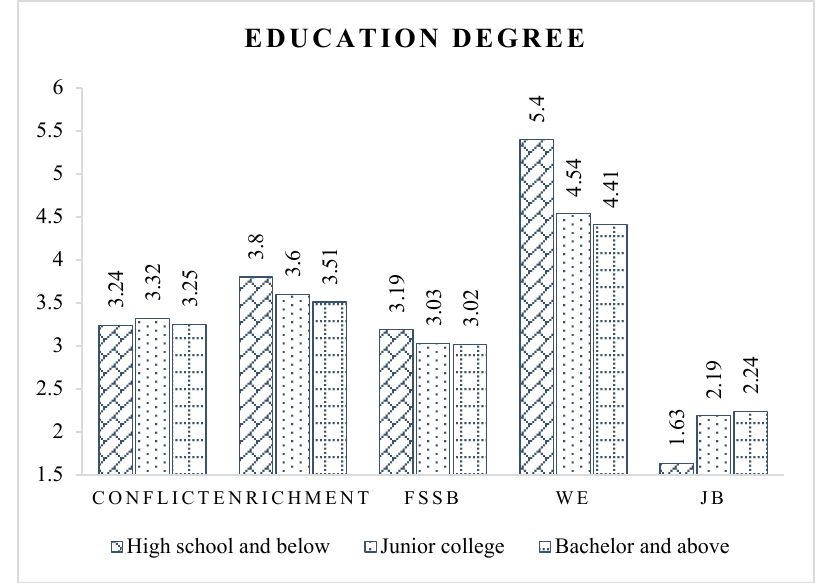
Figure 4. Latent variable scores of different education degree groups.